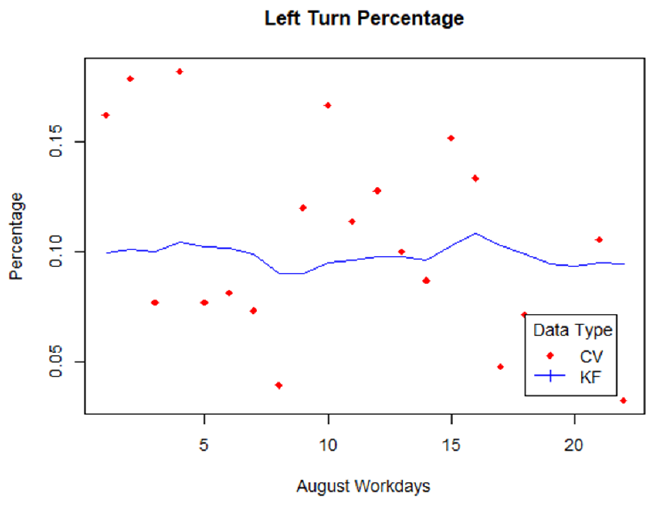
Figure 8. Northbound Left Turns 4:15 to 6:15 p.m. August, 2021.